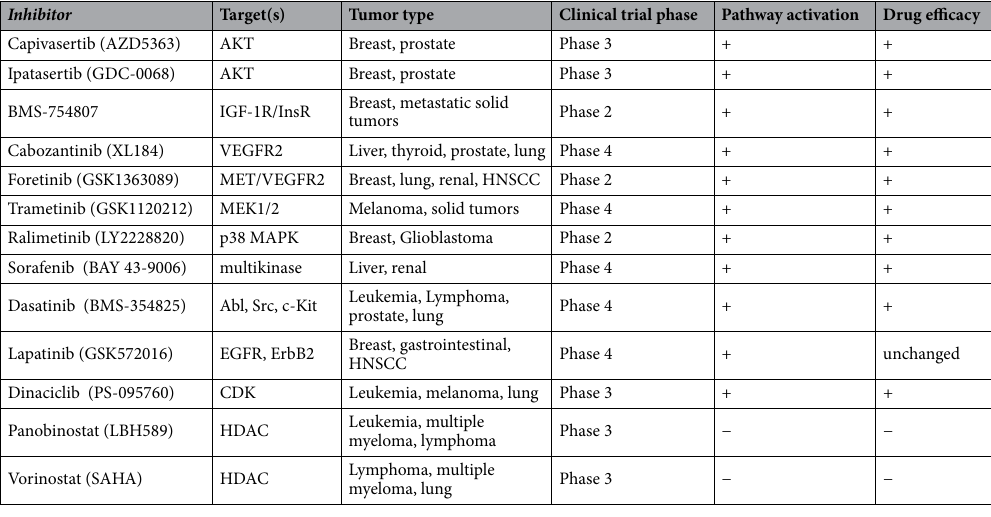
Table 1. Overview of the inhibitors used for the experiments in Figs. 6 and 7, their main molecular targets, the disease site for which clinical trials have been performed and the clinical trial phase. The last 2 columns show the pathway activation status at 2 months after a single-dose (SD) irradiation of 10 Gy and the efficacy of the inhibitor in 10 Gy SD long-term